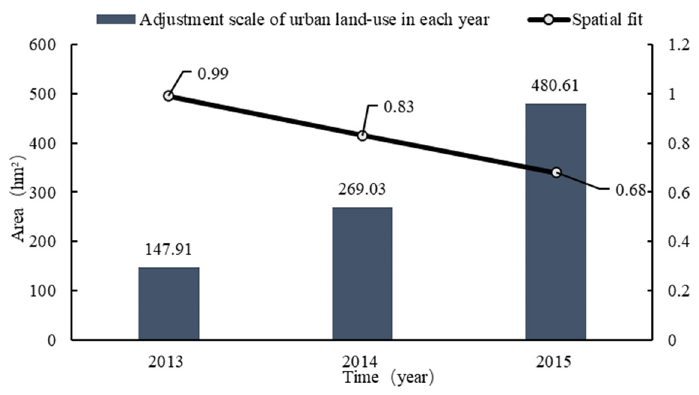
Figure 7. The spatial consistency between land-use change and land-use master plan adjustment.